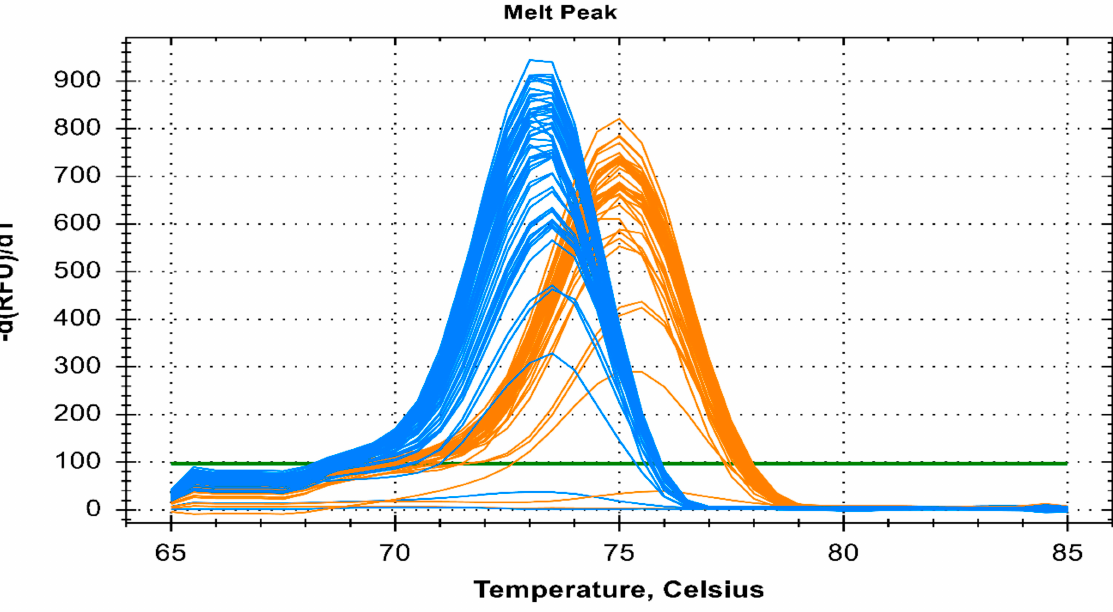
Figure 2. Melt curve analysis of clinical fifty Pf and forty Pv samples depicted by blue and orange color respectively. The melting temp (T m ) for Pf and Pv of clinical samples were 73.5 ◦ C ± 0.5 ◦ C and 75 ◦ C ± 0.5 ◦ C